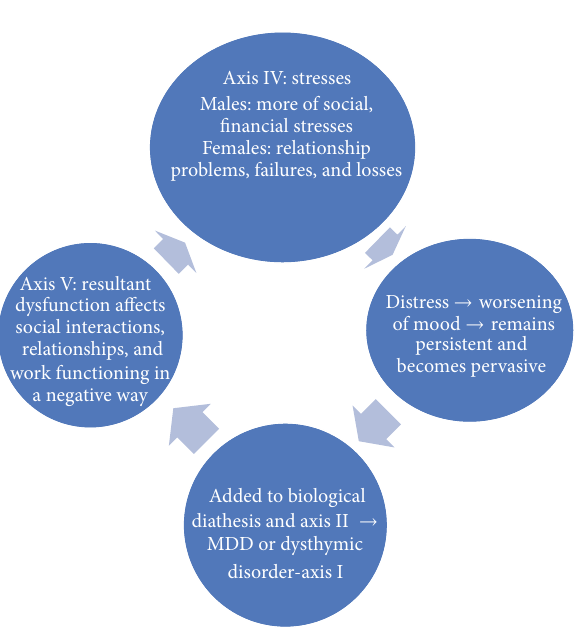
Figure 1: Interactive model of axes I, IV, and V in